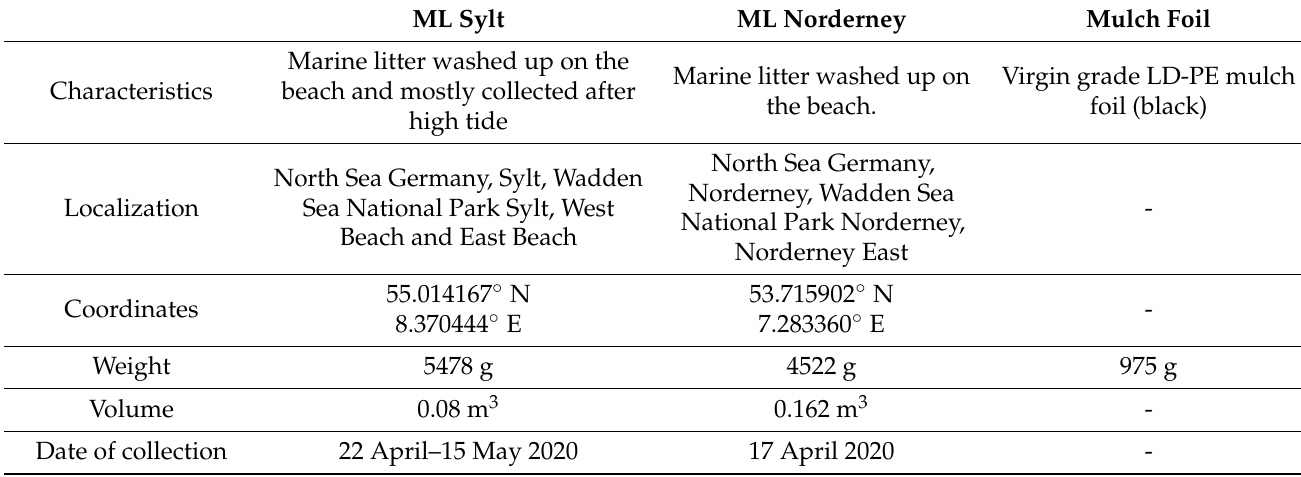
Table 2. Material characteristics of the two batches of marine litter and mulch